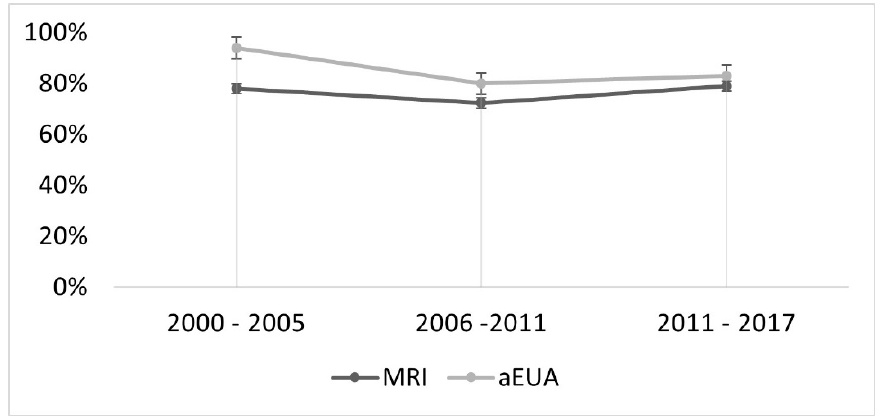
Figure 3. Line graph indicating change in accuracy of MRI and aEUA over time. There was no significant change for both methods ( p = 0.06 for aEUA and p = 0.34 for MRI).